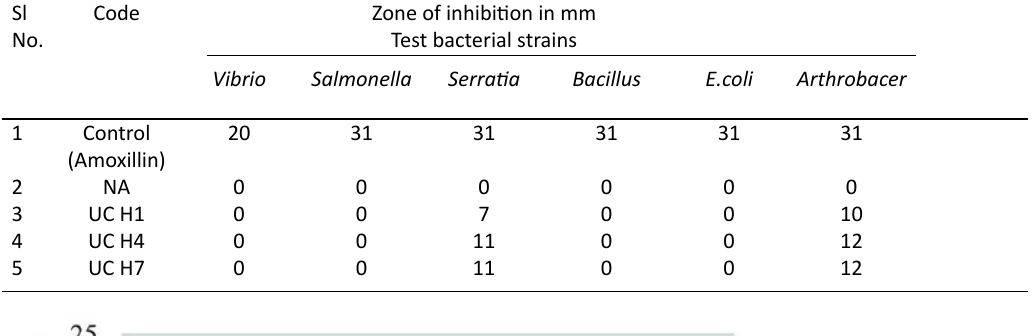
Table 3. Antibacterial activity of three endophytic bacterial isolates Sl Code Zone of inhibition in mm No. Test bacterial strains Vibrio Salmonella Serratia Bacillus